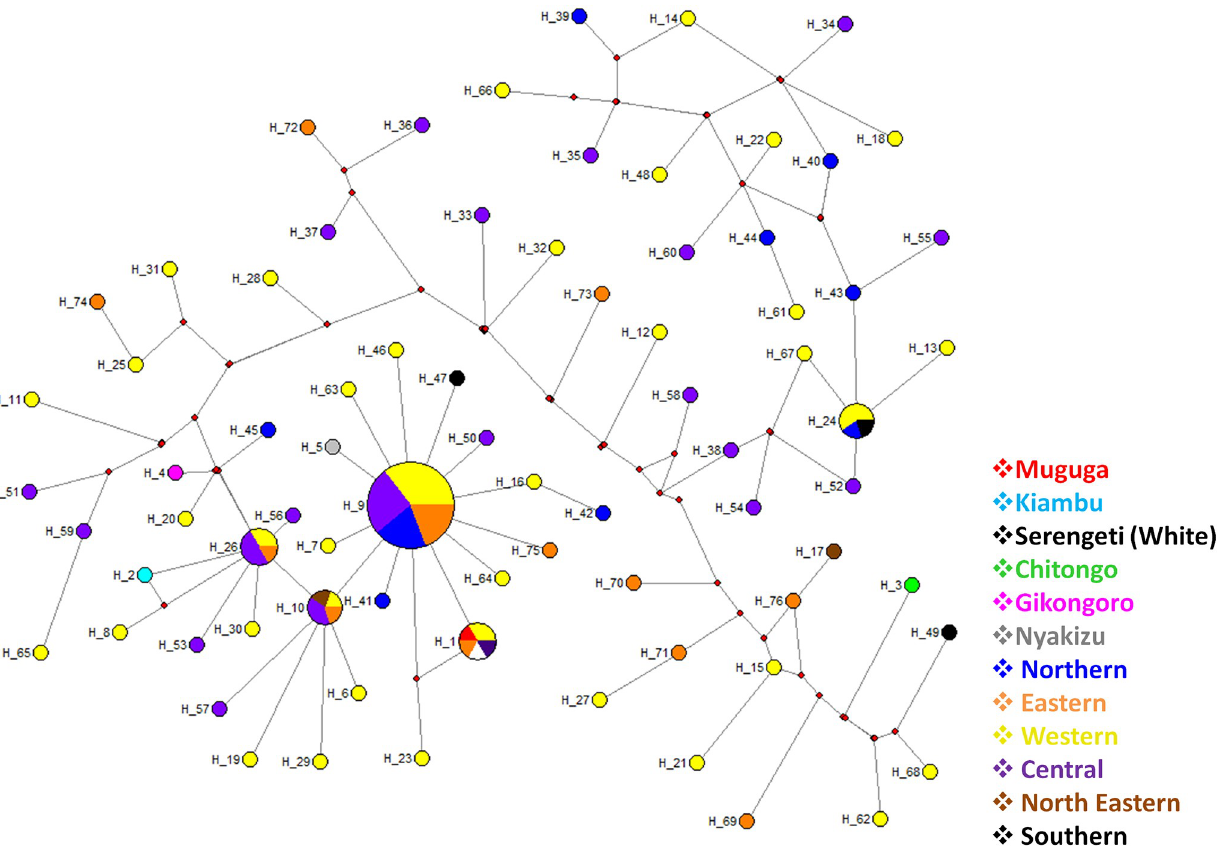
Fig 6. Tp2 network median-joining network based on the polymorphic sites of Tp2 from Burundi showing star-like radiation pattern of haplotypes. The sizes of the circles correspond to haplotype frequencies. The colour codes denote the places of origin of the samples.